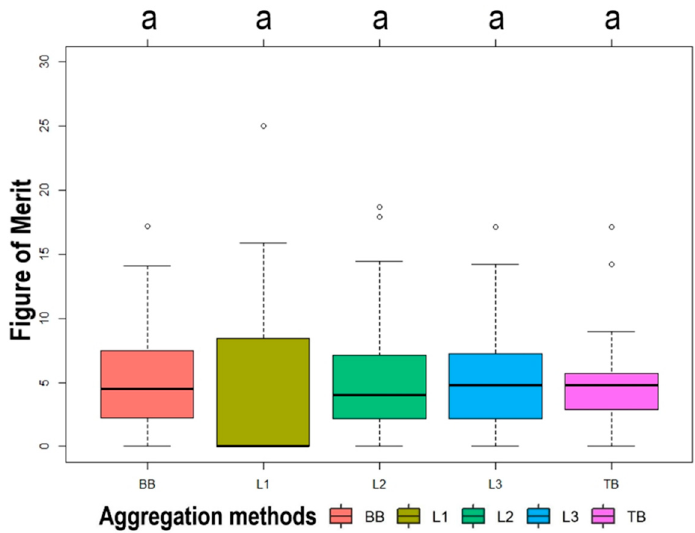
Figure 6. Figure of Merit (FOM) values grouped by the aggregation method. No groups are significantly di ff erent, therefore the single letter a at the top applies to all groups. (BB = Behavior-based aggregation; L1 = Corine Standard Level 1 aggregation; L2 = Corine Standard Level 2 aggregation; L3 = Corine Standard Level 3 aggregation). BB, L1, L2, L3 and TB groups include 24,24,24,24 and 18 model runs, respectively. The vertical middle line shows the median, the box boundaries show the first and third quartiles of the group, whiskers show the minimum and maximum values that are not outliers, while points show the outliers.